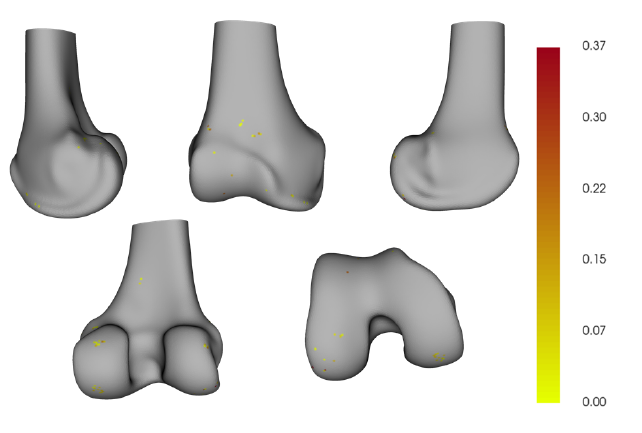
Figure 4. A medial, anterior, lateral, posterior, and distal view of the vertex importance for the